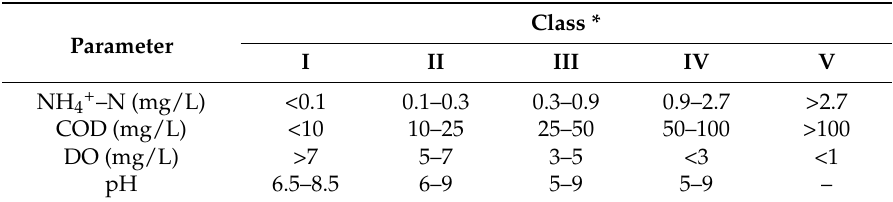
Table 2. Natural water quality standards in Malaysia